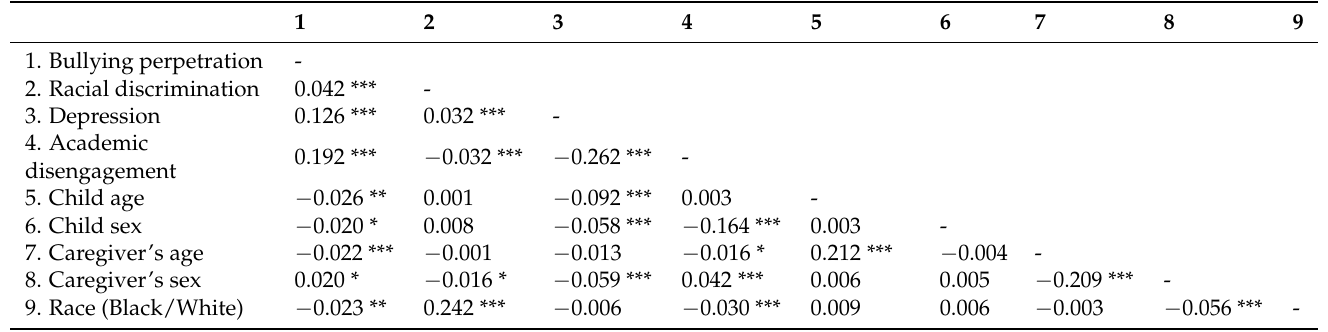
Table 2. Bivariate Correlations of the Main Study Variables.